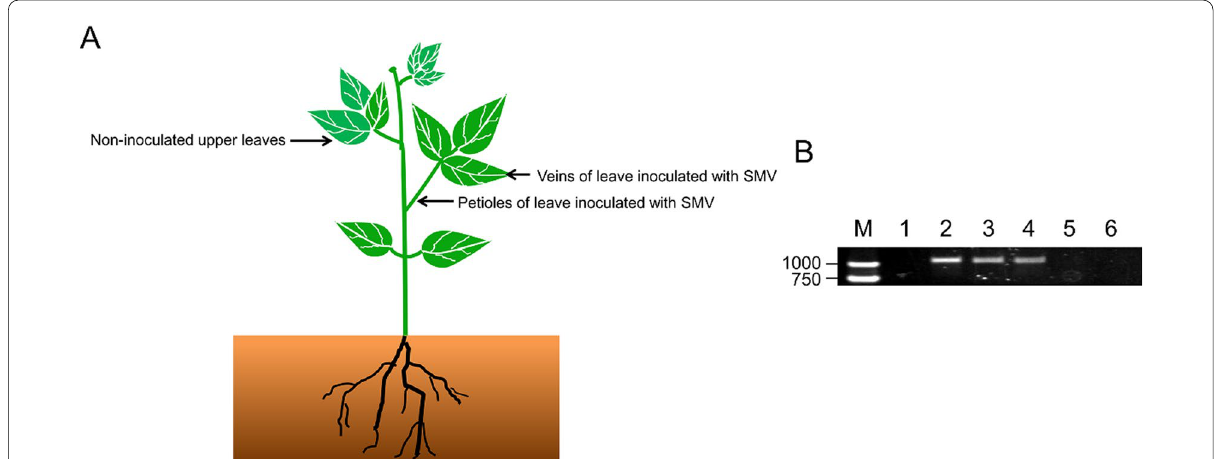
Fig. 2 Spread of SMV in the incompatible host. A Schematic diagram showing plants inoculated with SMV; B Detection of SMV- CP gene by RT-PCR analysis from different tissues of soybean plants. M: DL2000bp DNA marker; 1: negative control (simulated inoculation with water); 2: positive control (Jihuang 13 leaves inoculated with SC-8); 3: the veins of inoculated leaves; 4: the petiole of inoculated leaves; 5: the stem; 6: non-inoculated upper leaves